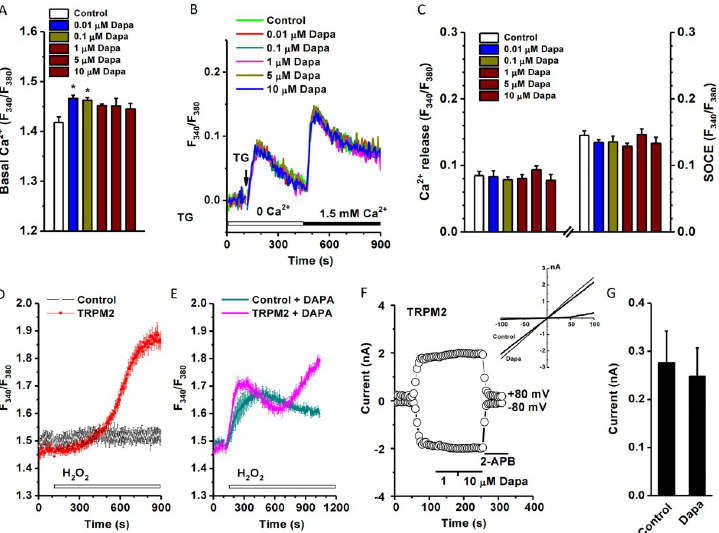
Fig 7. Effect of dapagliflozin on basal [Ca 2+ ] i and Ca 2+ influx in HK-2-cells. HK-2 cells were seeded at a confluence of 6 × 10 4 cells/well and incubated for 12 hours before loading with Fura-PE3/AM (1 μ M). The ratio (F 340 /F 380 ) was measured using FlexStation 3. A, Mean ± SEM data for the basal Ca 2+ level ( n = 7 for each group). B, Effect on thapsigargin (TG, 1 μ M) induced Ca 2+ release and store-operated Ca 2+ entry (SOCE) after refilling with 1.5 mM Ca 2+ . C, Mean ± SEM data for (B) ( n = 7). D, HEK293 T-REx cells over-expressing with human TRPM2 and the activation by 1 mM H 2 O 2 ( n = 8). E, Dapagliflozin (Dapa) altered intracellular Ca 2+ dynamics related to the TRPM2 channels. F, No direct effect on TRPM2 channel activated by ADP-ribose (0.5 mM). G, Mean ± SEM data for (F) ( n = 4).